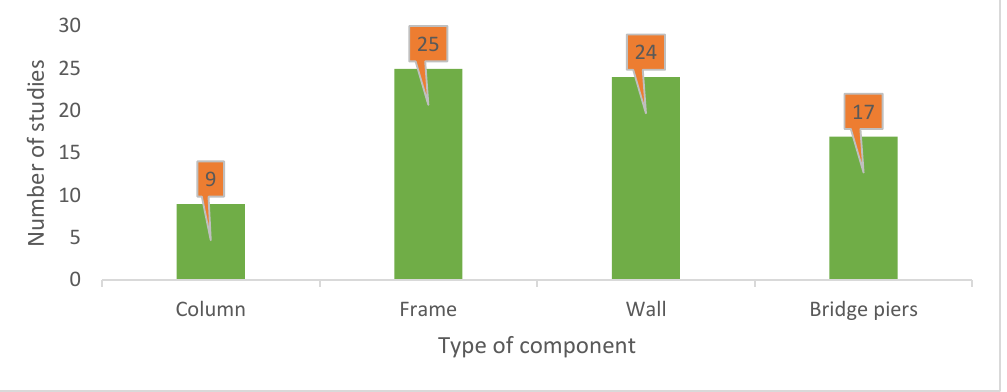
Figure 9. Visualization of the summarized research based on the investigated components.